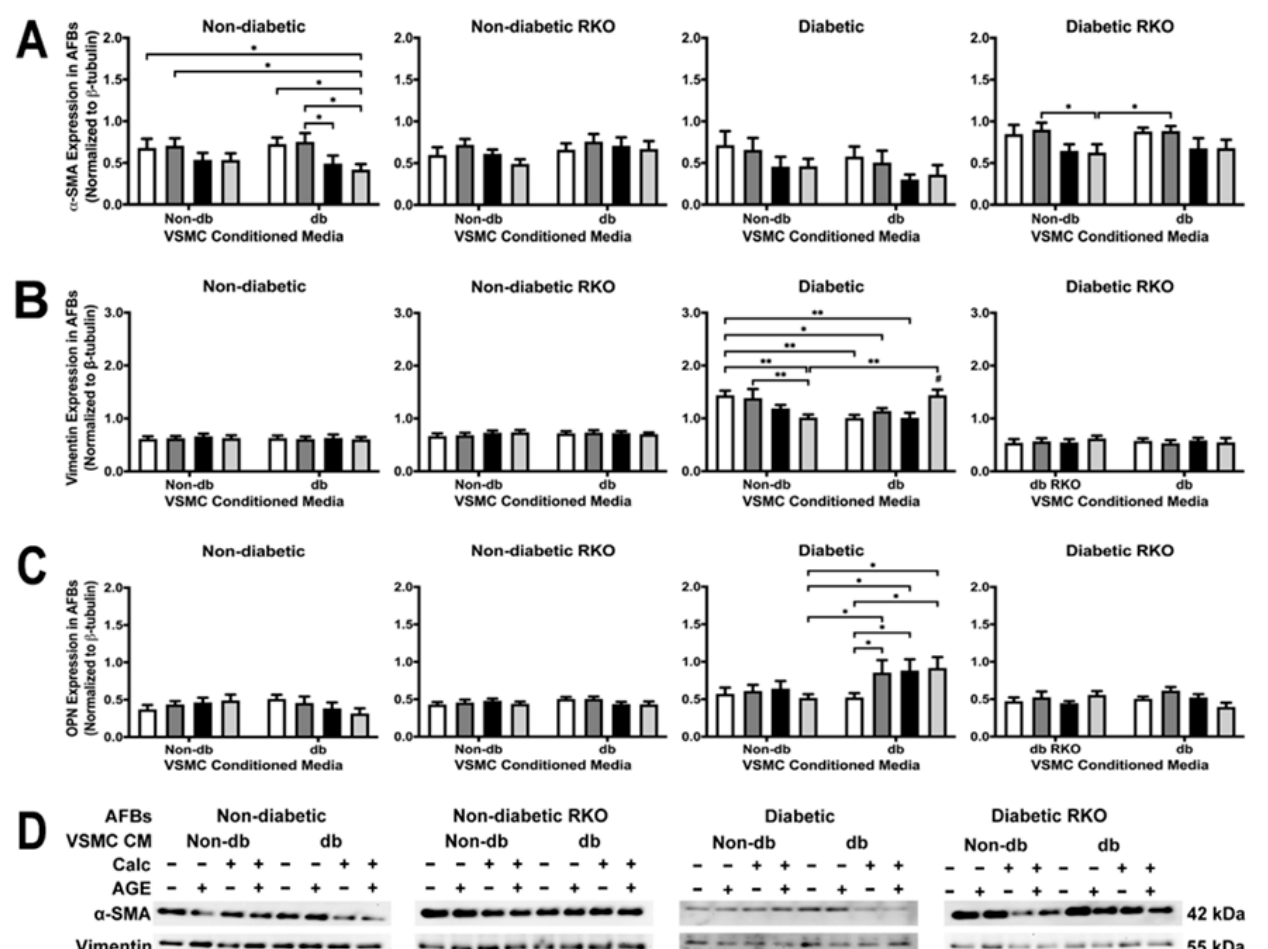
Figure 7. Primary AFBs were isolated and treated with VSMCs-conditioned media at a 1:10 dilution in 2% FBS genotype appropriate DMEM for 7 days. Protein expression was quantified of α -SMA (42 kDa: ( A )), vimentin (55 kDa: ( B )) and OPN (32 kDa: ( C )). All protein levels were normalized to β -tubulin, and ( D ) representative western blot images. Data was graphed as mean ± SEM with n = 3–6 of independent replicates. A two-way ANOVA with Fisher’s LSD post hoc was performed (# represents significant to all other groups within treatment group, * p < 0.05, ** p < 0.01) on each graph individually. All data were analyzed together with a two-way ANOVA to give the following: α - SMA (Interaction; p = 0.8482, Genotype; p < 0.0001, and Treatment; p = 0.0003), Vimentin (Interaction; p = 0.0002, Genotype; p < 0.0001, and Treatment; p = 0.2291), and OPN (Interaction; p = 0.0202, Genotype; p < 0.0001, and Treatment; p =